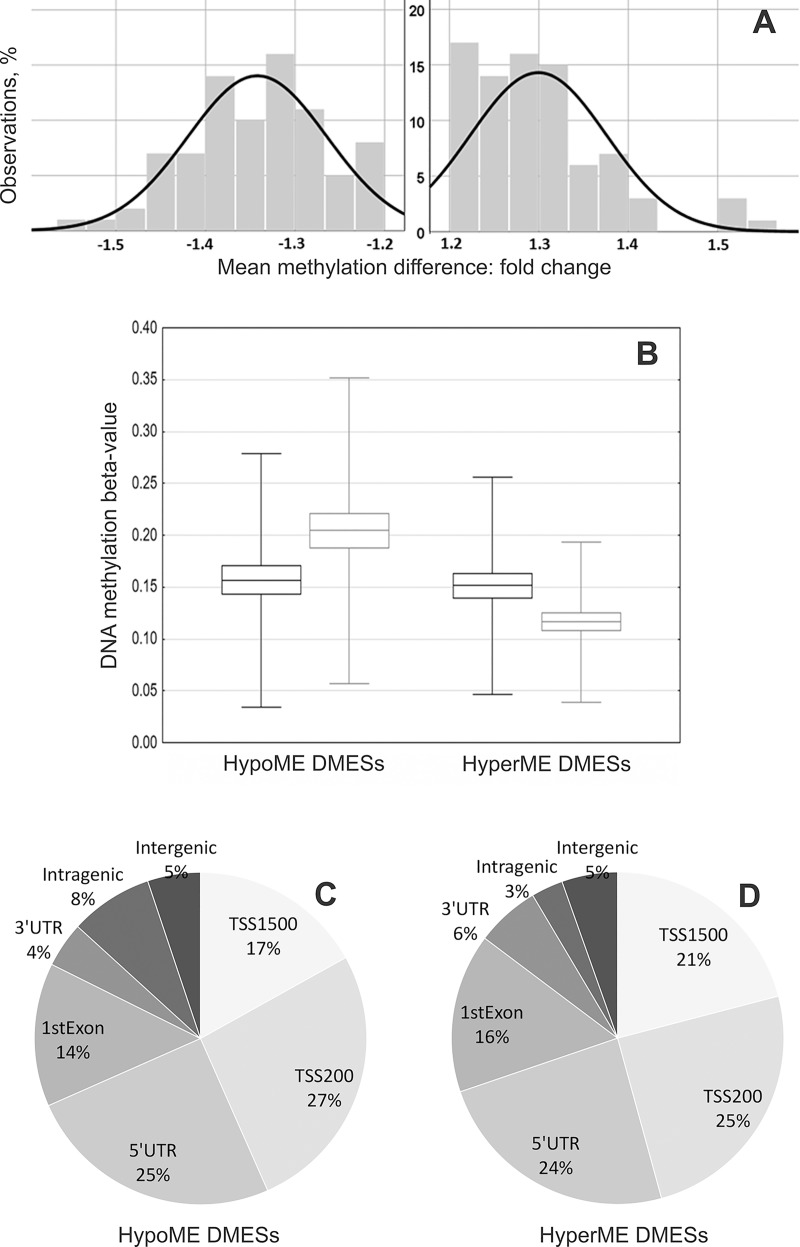
The range of variability for differential methylation indices of the 164 DMESs and their genomic localizations.(A) Distribution of the differential methylation measurement, Fold change; hypermethylation and hypomethylation events in the IC group are shown on the X-axis as positive and negative Fold change values, respectively; the Y-axis represents the number of observations. (B) Box-plots of group differences in the average beta-values for the set of 164 CpG sites—82 hypomethylated (HypoME DMESs) and 82 hypermethylated (HyperME DMESs)—between the IC (black boxes) and BFC (grey boxes) groups of children. Diagrams showing the distribution of hypomethylated (C) and hypermethylated (D) DMESs with respect to their genic region annotation: 1st exon, gene body, 3' or 5' untranslated region (UTR), and promoter-associated region upstream a transcription start site (TSS).